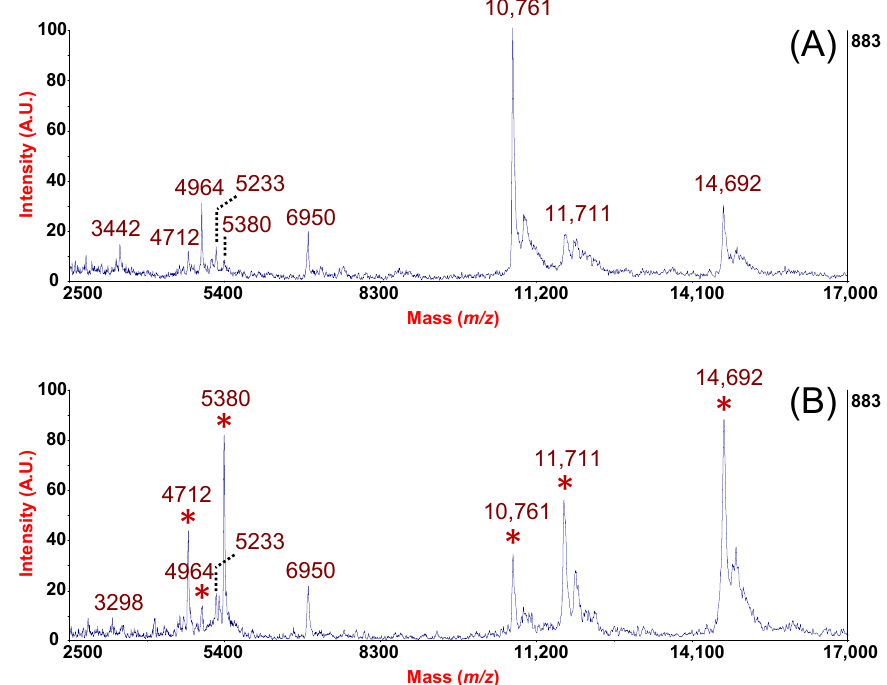
Figure 3. Rhino-peptidomic fingerprints of NF processed by MPS-C from a patient suffering from NARMA CRS with UNP before ( A ) and after nasal polypectomy ( B ). Peaks of AMP that showed changes in the levels of expression after the removal of nasal polyps are marked by asterisks in panel B.